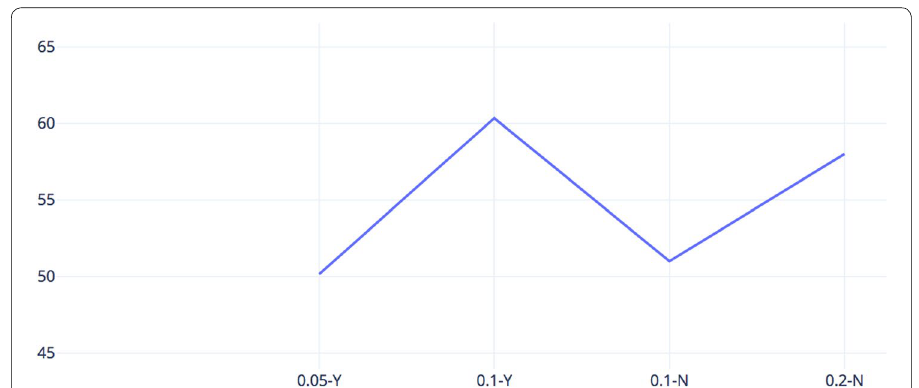
Fig. 8 Comparison of various NB and DF configurations—recall